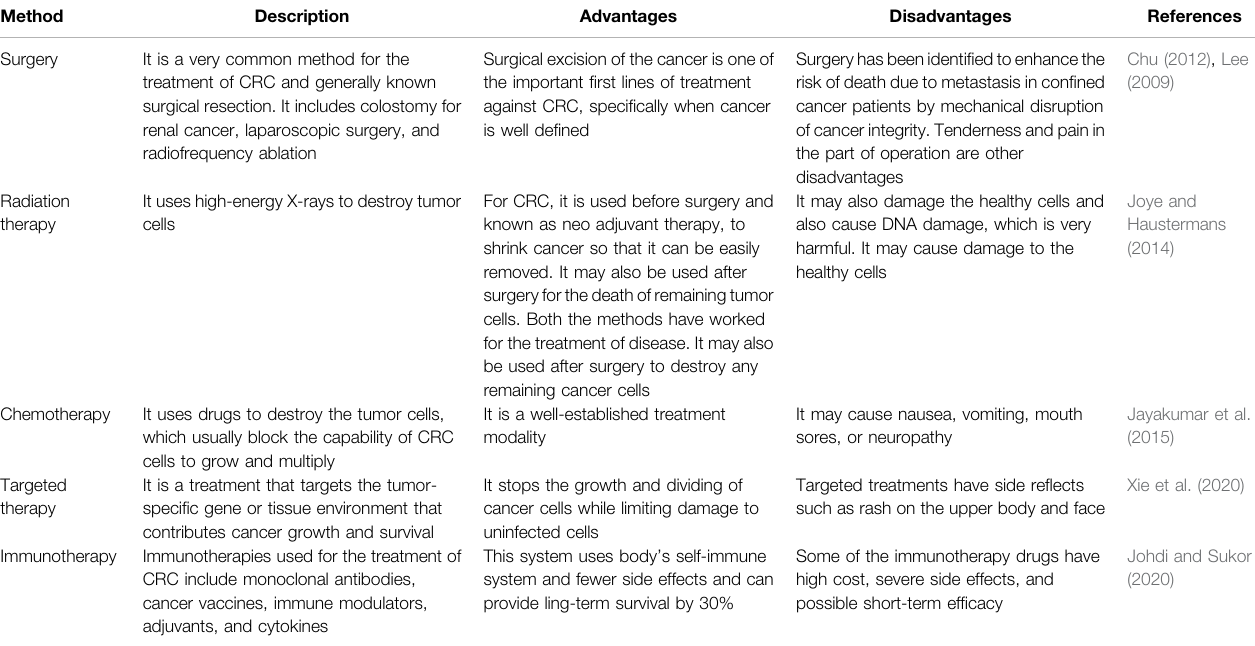
TABLE 2 | Various existing methods with merits and demerits for the treatment of